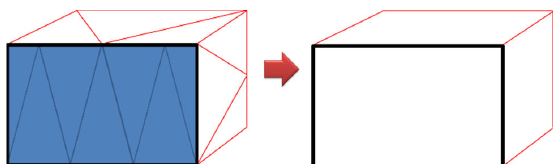
Figure 4. An example of region growing and outline detection: The blue triangles belong to a group because one triangle is connected to at least one other triangle with a parallel normal. The outline of the group (black line) consists of the edges that belong only to one triangle.